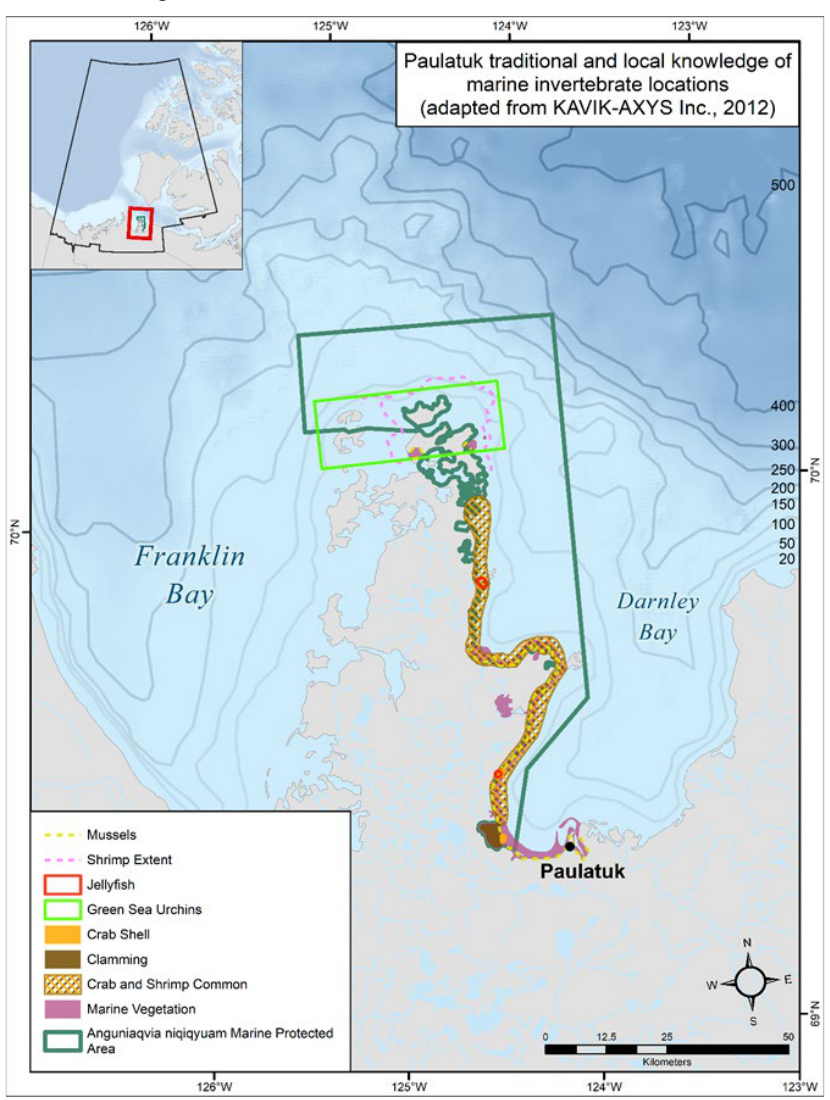
Figure 13. Locations of key marine invertebrate habitats and invertebrate harvesting areas in the vicinity of the ANMPA from traditional and local knowledge gathered during a workshop in Paulatuk in 2011. Map adapted from KAVIK-AXYS Inc. (2012) by J. Friesen and provided by the ANMPA Working